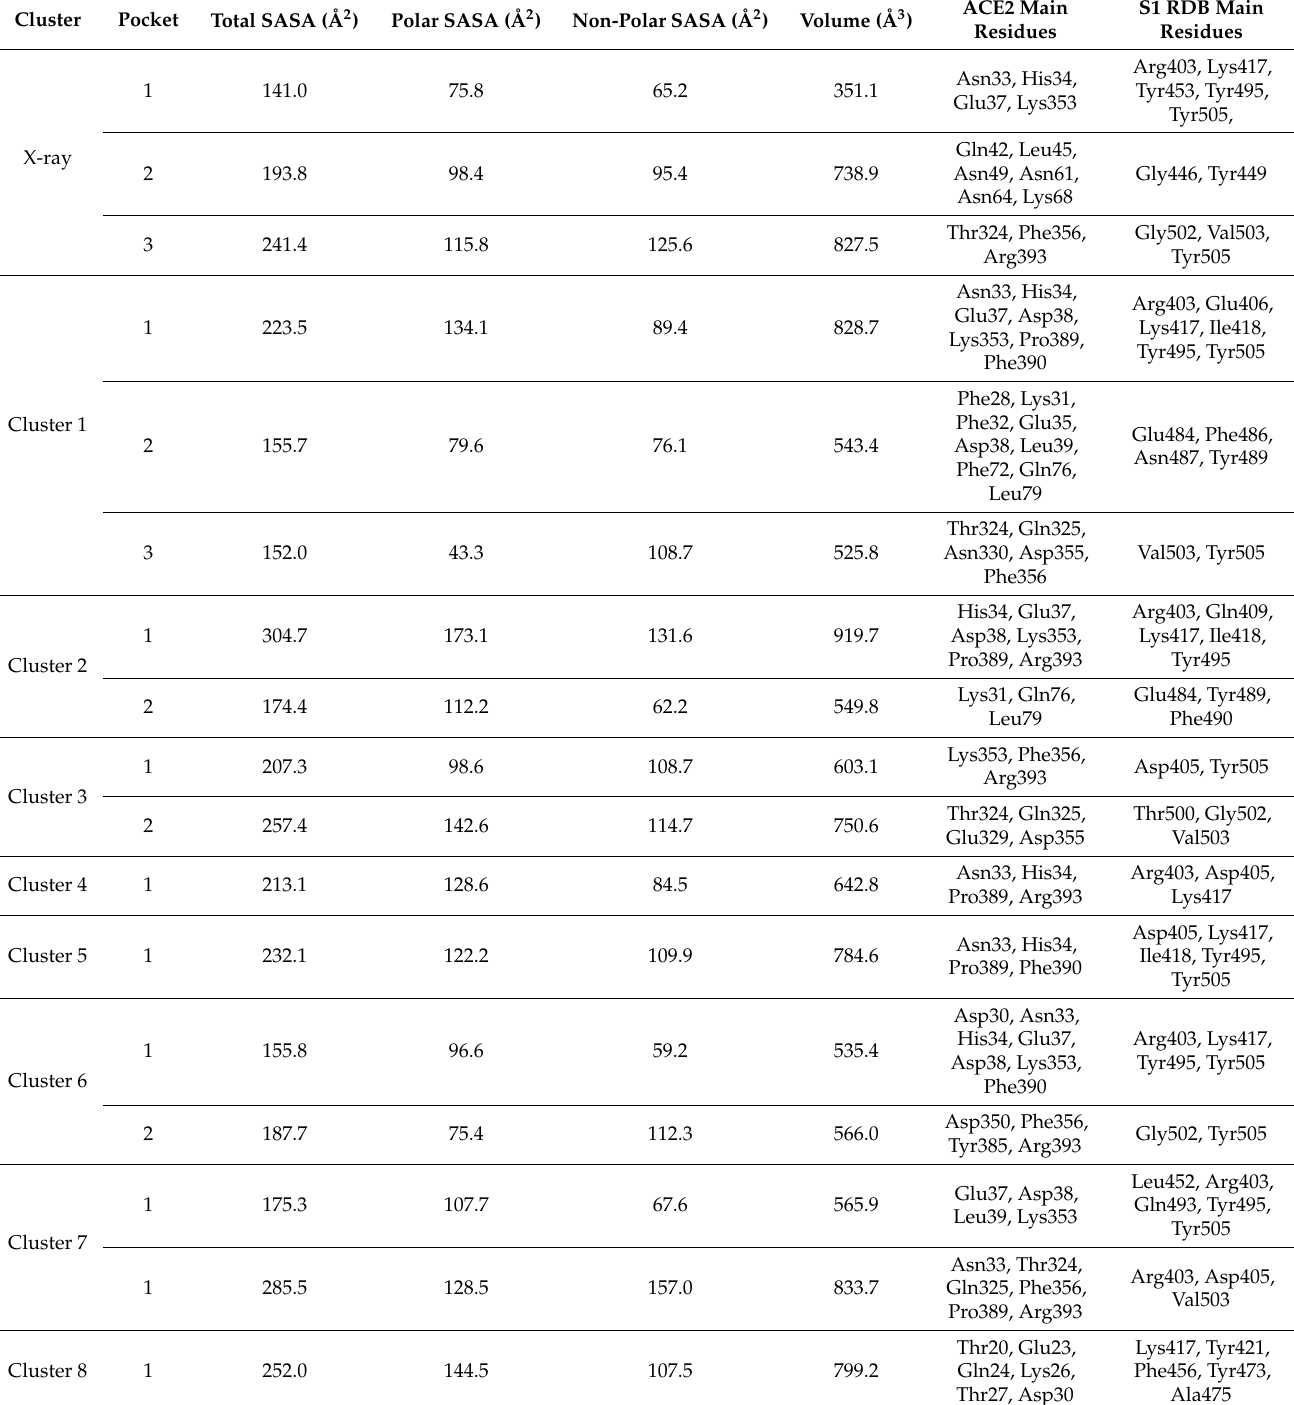
Table 1. Characterization of the binding pockets identified on the X-ray structure and on the 8 representative structures obtained from the cluster analysis in terms of SASA (solvent accessible surface area), volume and main interacting amino acid residues at the angiotensin-converting enzyme 2 (ACE2) and S1 RBD interface. Values obtained with